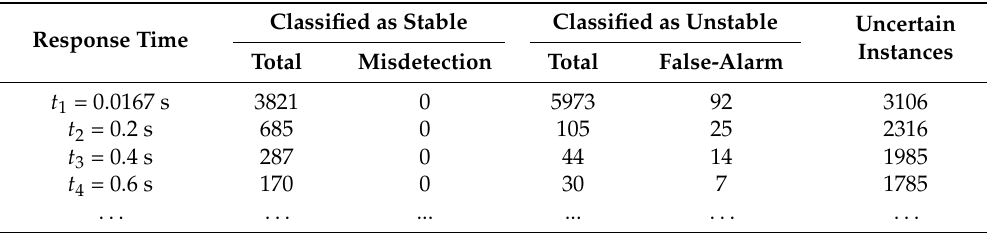
Table 3. Prediction results of the hierarchical